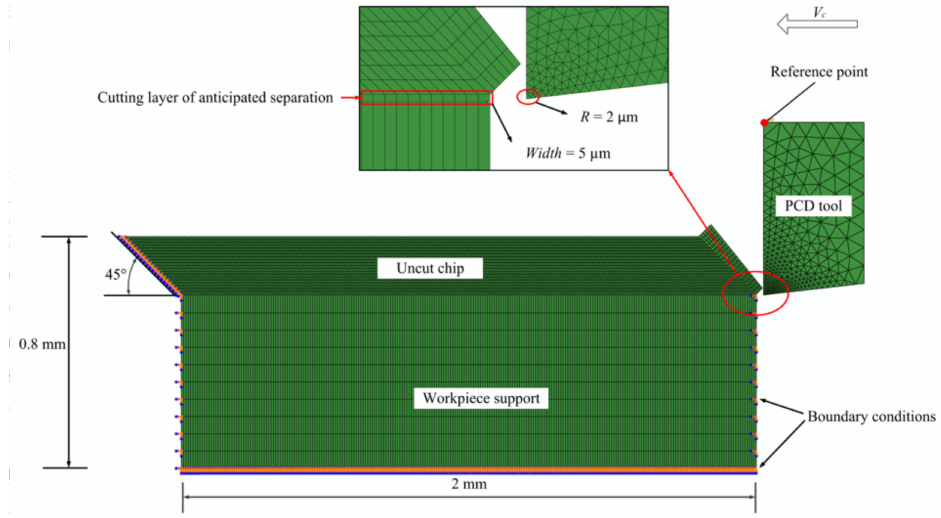
Figure 5. Geometric model for two-dimensional (2D) orthogonal cutting process